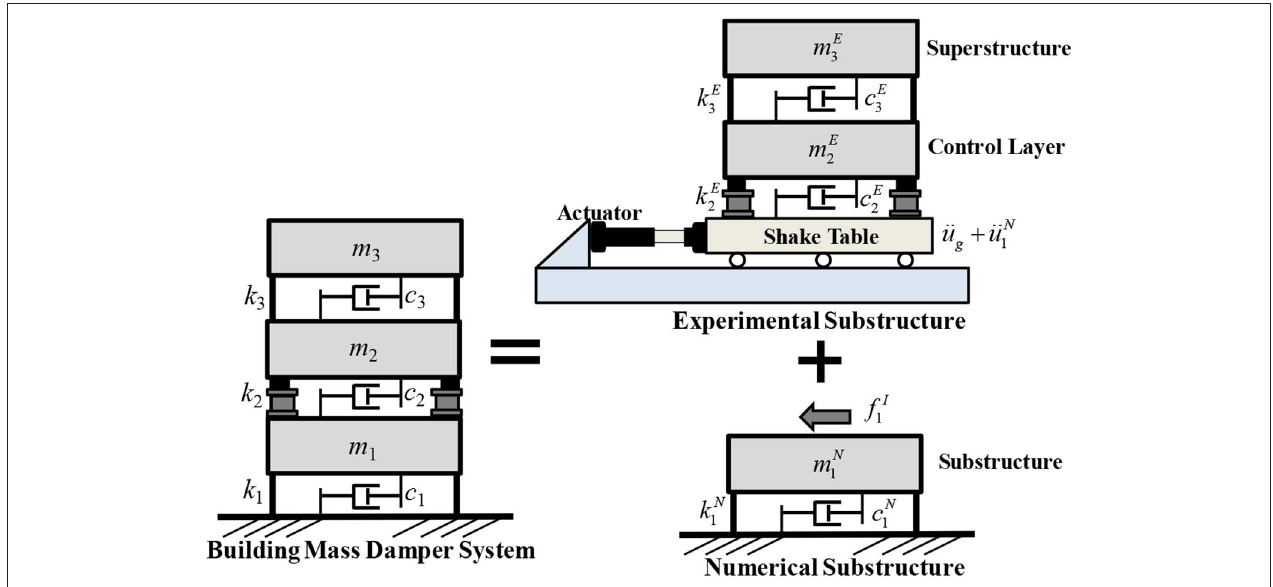
FIGURE 2 | Illustration of the substructuring for RTHS of a BMD